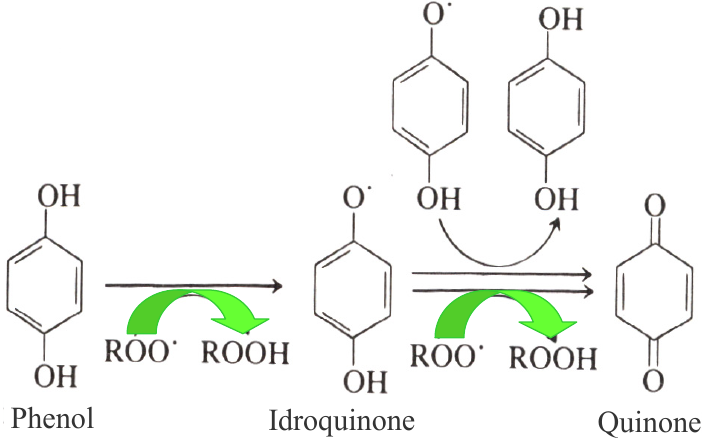
Figure 1. Mechanism of the antioxidant activity of Olive Phenols (Ops) on EVOO.